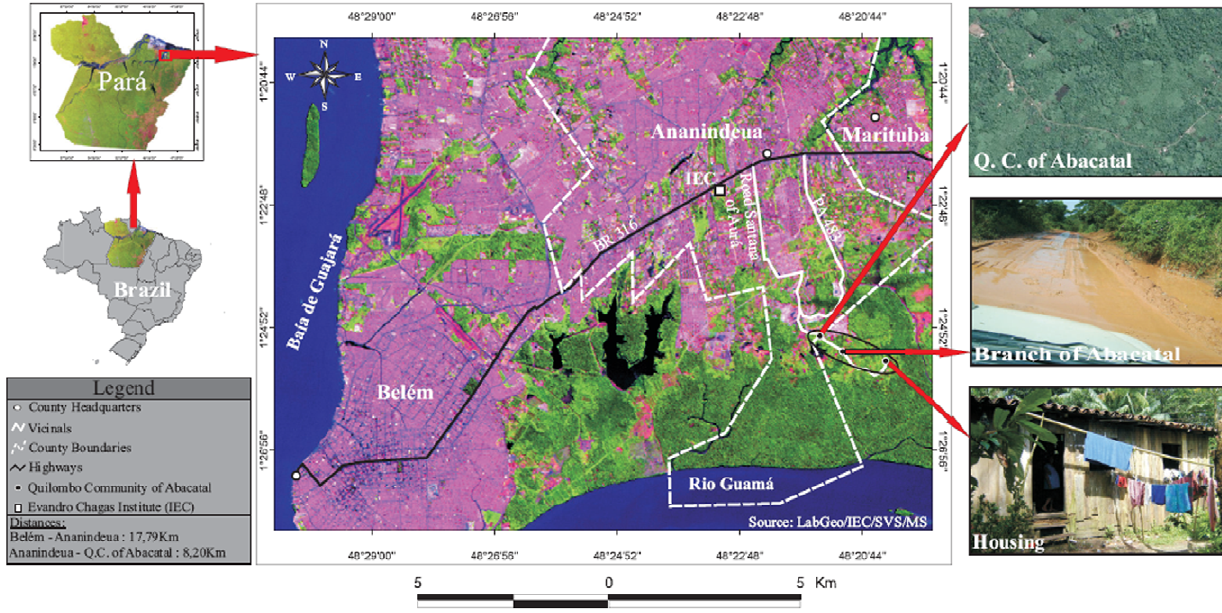
Figure 1. Map showing the location of the Abacatal ‘‘Quilombola’’ Community, in the metropolitan region of Bele´m city, Para´ State, Amazon region, Brazil.